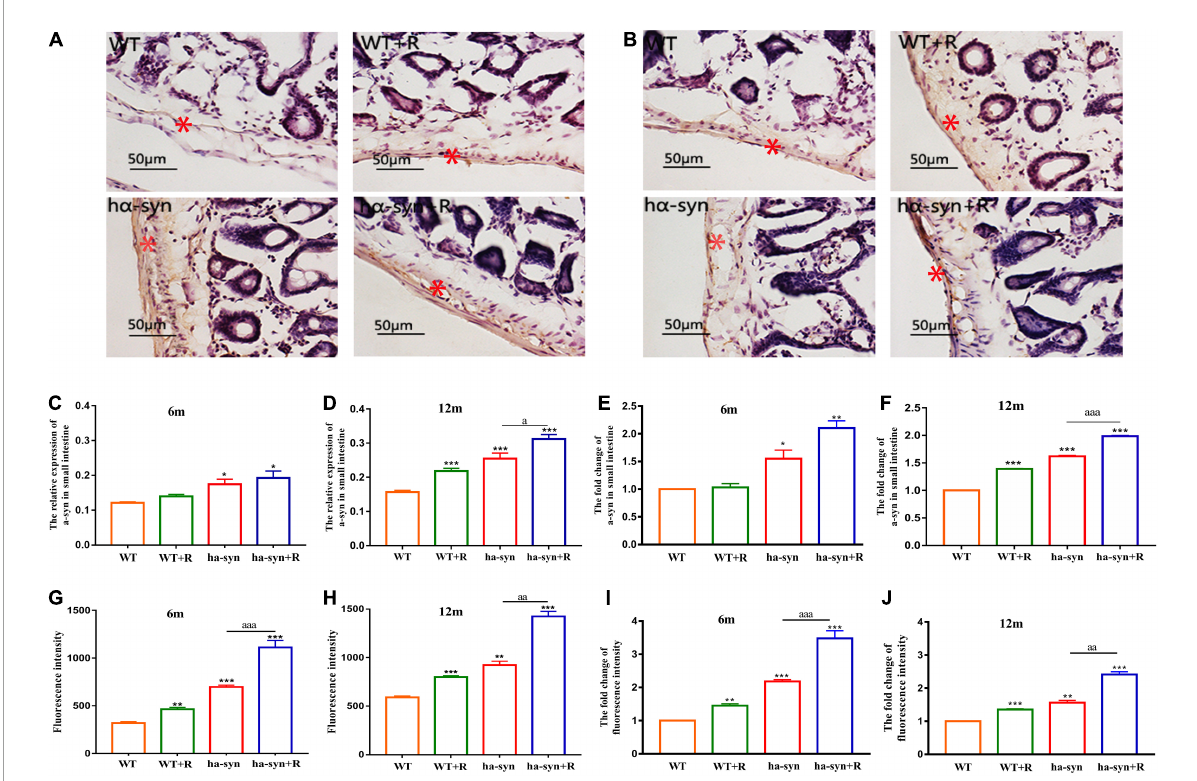
FIGURE4 Rotenone significantly elevated intestinal α -syn levels in h α -syn + / − mice and may affect intestinal permeability. The expression levels of α -syn in the intestinal were detected by immunohistochemical technique at different ages (A–F) . (A) Representative images of α -syn expression in the small intestine of 6-month-old h α -syn + / − mice, and the red asterisk represents the positive area. (B) Representative images of α -syn expression in the small intestine of 12-month-old h α -syn + / − mice, and the red asterisk represents the positive area. (C) Grayscale analysis of α -syn expression in the small intestine of 6-month-old h α -syn + / − mice by ImageJ. (D) Grayscale analysis of α -syn expression in the small intestine of 12-month-old h α -syn + / − mice by the ImageJ software. (E) The fold change of α -syn expression in the small intestine of 6-month-old h α -syn + / − mice compared with the WT group. (F) The fold change of α -syn expression in the small intestine of 12-month-old h α -syn + / − mice compared with the WT group. The FITC fluorescence is used to evaluate intestinal mucosal permeability (G–J) . (G) Fluorescence intensity analysis of FITC in the serum of 6-month-old h α -syn + / − mice. (H) Fluorescence intensity analysis of FITC in the serum of 12-month-old h α -syn + / − mice. (I) The fold change of FITC in the serum of 6-month-old h α -syn + / − mice compared with the WT group. (J) The fold change of FITC in the serum of 12-month-old h α -syn + / − mice compared with the WT group. n = 6. * P < 0.05, ** P < 0.01, *** P < 0.001, compared with the age-matched WT group. a P < 0.05, aa P < 0.01, aaa P < 0.001, compared with the age-matched h α -syn + / −